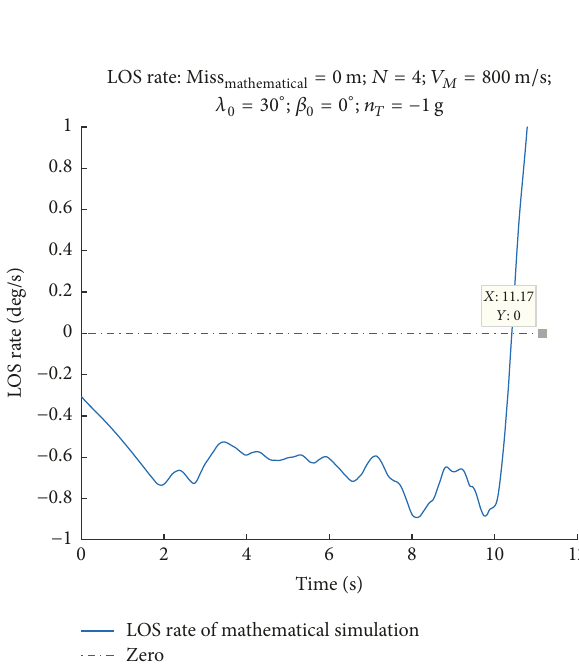
Figure 9: LOS rate of engagement mathematical simulation.